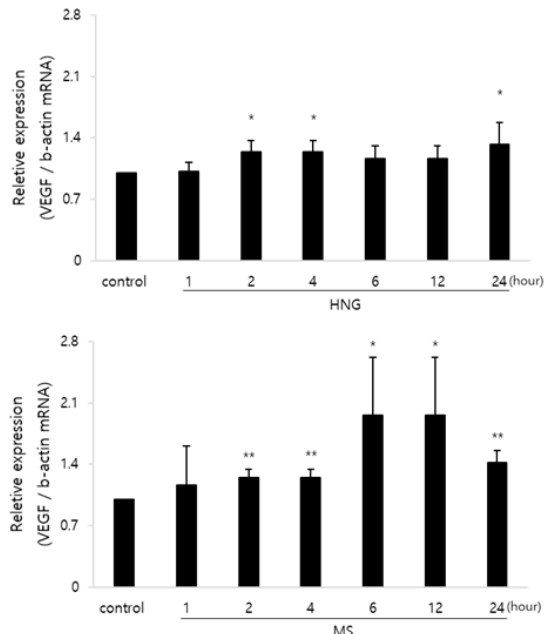
Figure 5. The expression level of vascular endothelial growth factor (VEGF) in DPCs treated with HNG. DPCs (1 × 10 5 cells / mL) were seeded in DMEM supplemented with 0.5% FBS. After 24 h, the cells were treated with HNG 200 nM for the indicated time. The expression level of VEGF mRNA was evaluated using real-time PCR and normalized to β -actin mRNA. Data are shown as the mean ± S.D * p < 0.05, ** p < 0.01 vs. control .